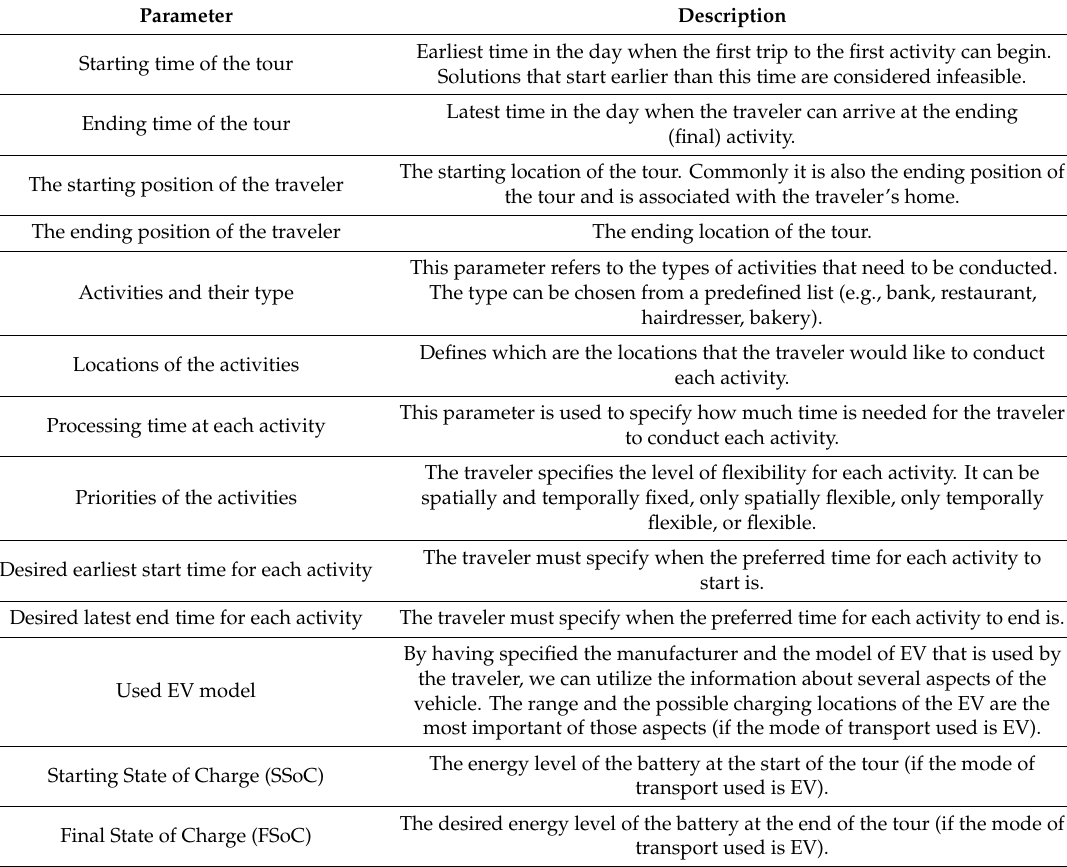
Table 1. The first group of